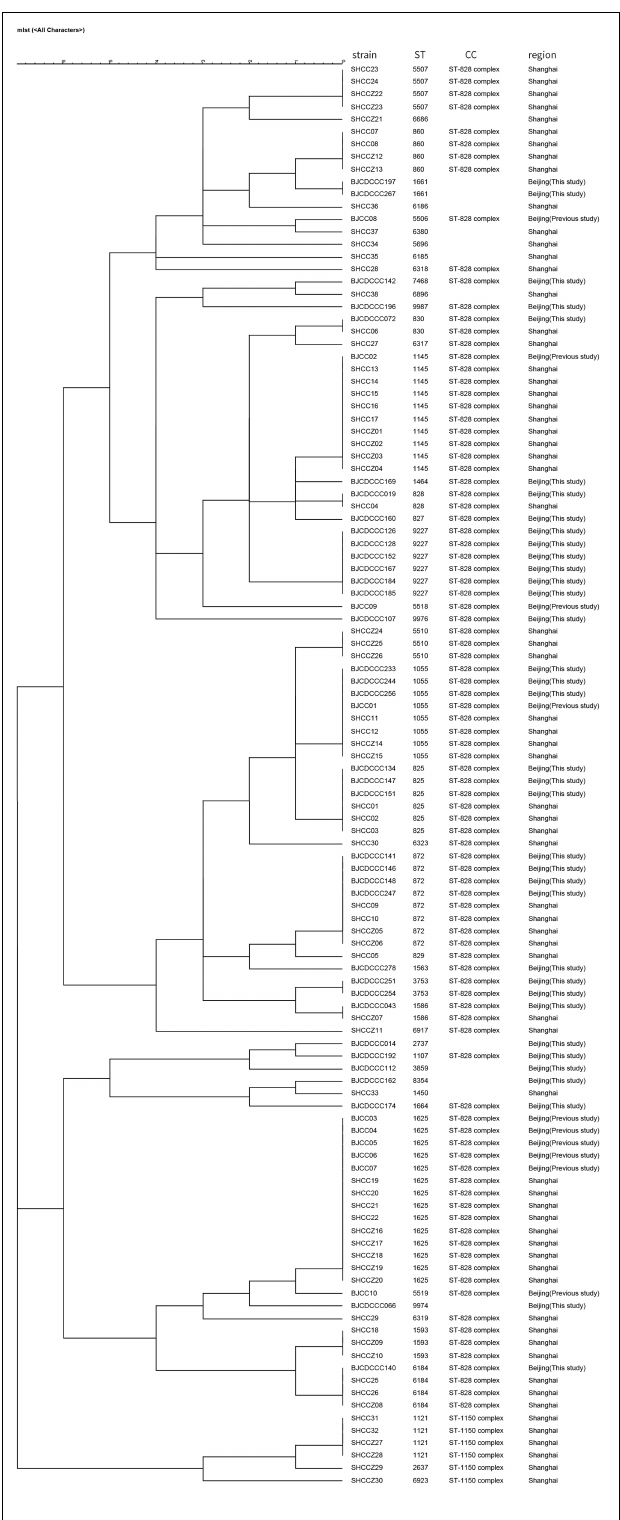
FIGURE 4 | Dendrogram of MLST data of C. coli human isolates collected from this study and other district of China, showed the number of differences in MLST alleles. The similarity coefficient were calculated using the categorical (difference) and complete linkage for the cluster